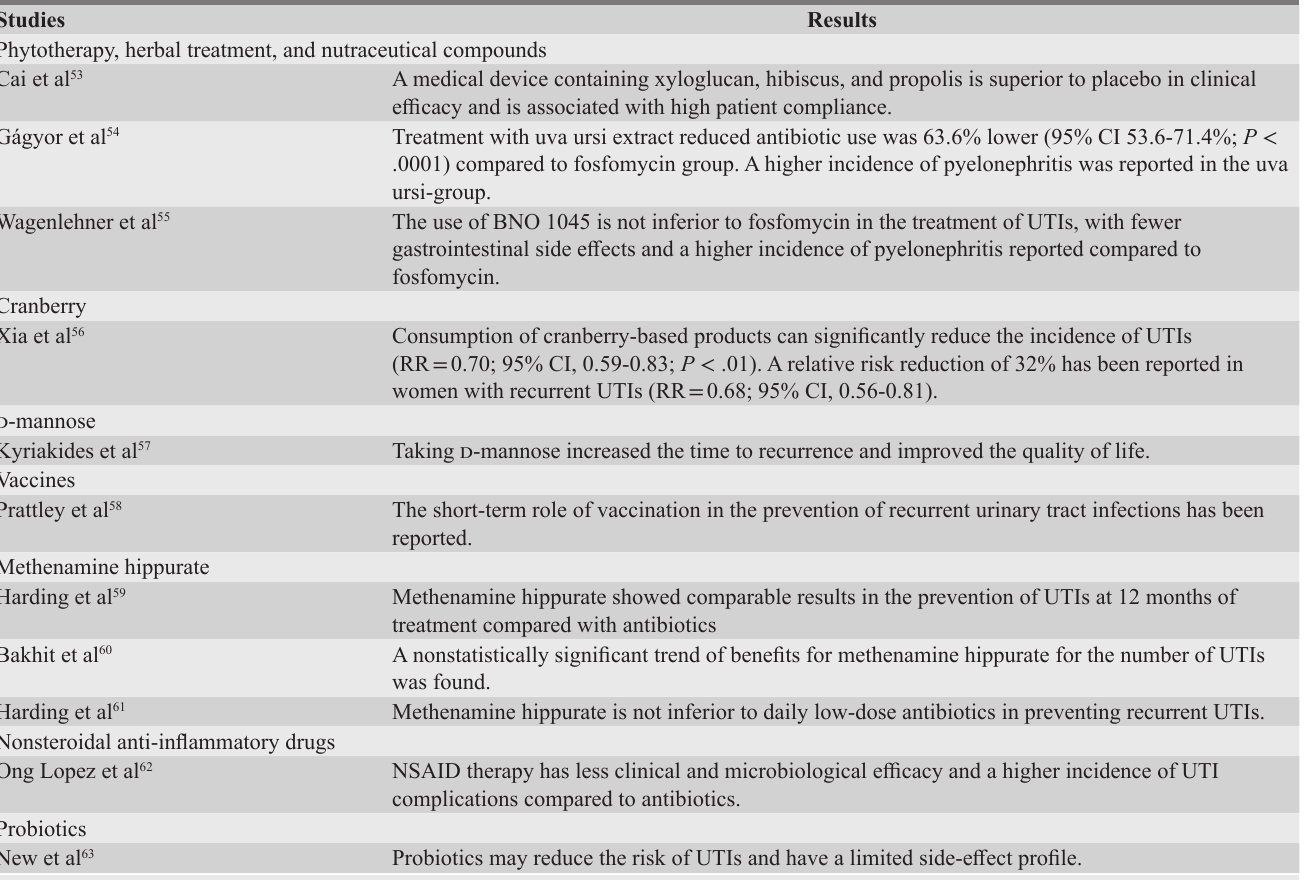
Table 2. Non-Antimicrobial Methods of Treatment and Prevention of Urinary Tract Infections Studies